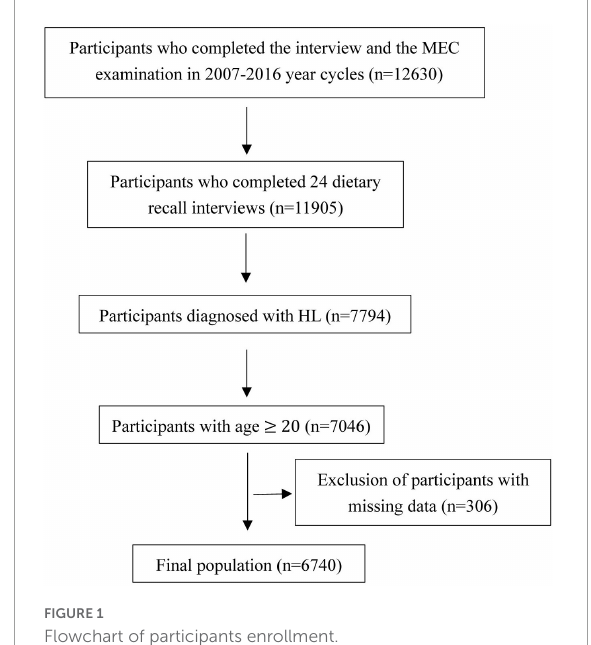
FIGURE1 Flowchart of participants enrollment.